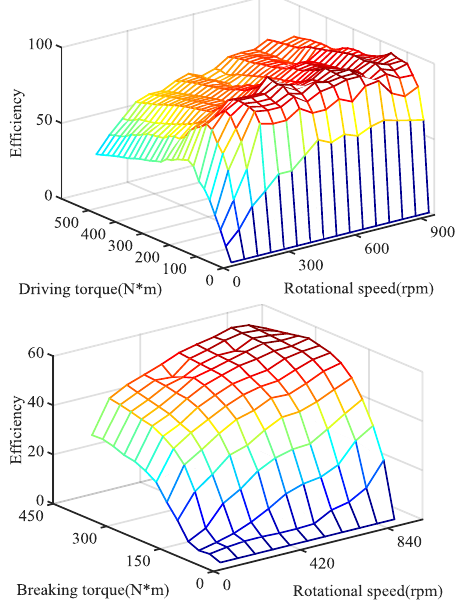
Figure 6 Driving and braking ef fi ciency map of the DC in-wheel motors